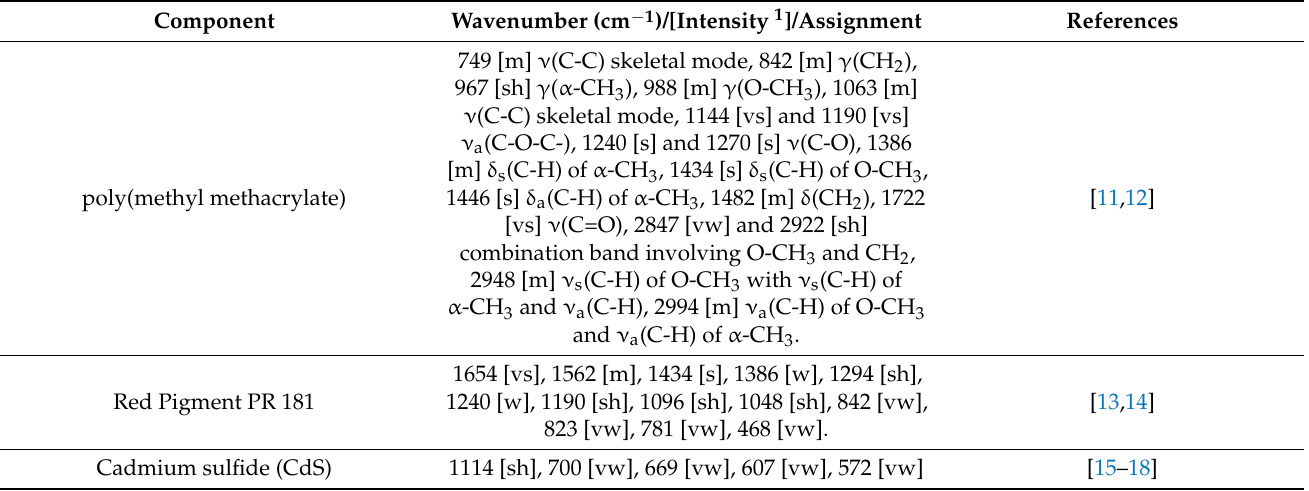
Table 2. ATR-FTIR absorption bands associated with the analyzed compounds in the Paisaje Abstacto sample. The anti-symmetric and symmetric stretching and blending modes are denoted with ν a , ν s , a and s